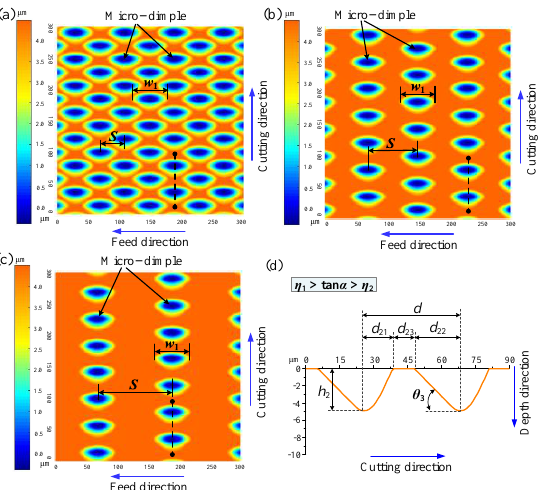
Figure 21. Simulated surface topographies and dimple profile under processing parameters of f us =